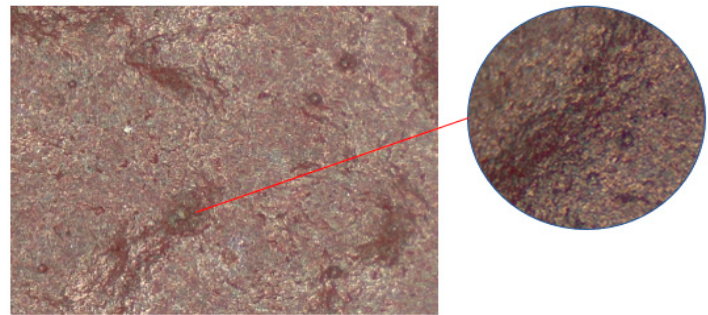
Figure 15. Rust spots on the surface of the no-WBM specimen with a primer thickness of 50–80 μ m.